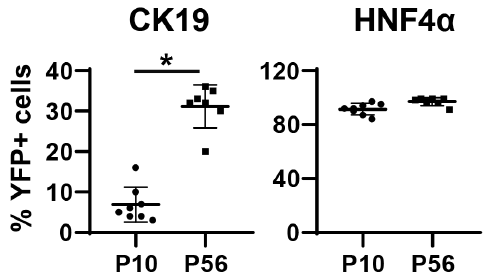
Figure 6. Quantification of the percentage of AAV8-TBG-Cre / YFP-labeled cells within CK19-expressing cholangiocytes and HNF4 α -expressing hepatocytes. Error bars represent the standard deviation of the mean ( n = 7–8 mice per group). * p < 0.05.